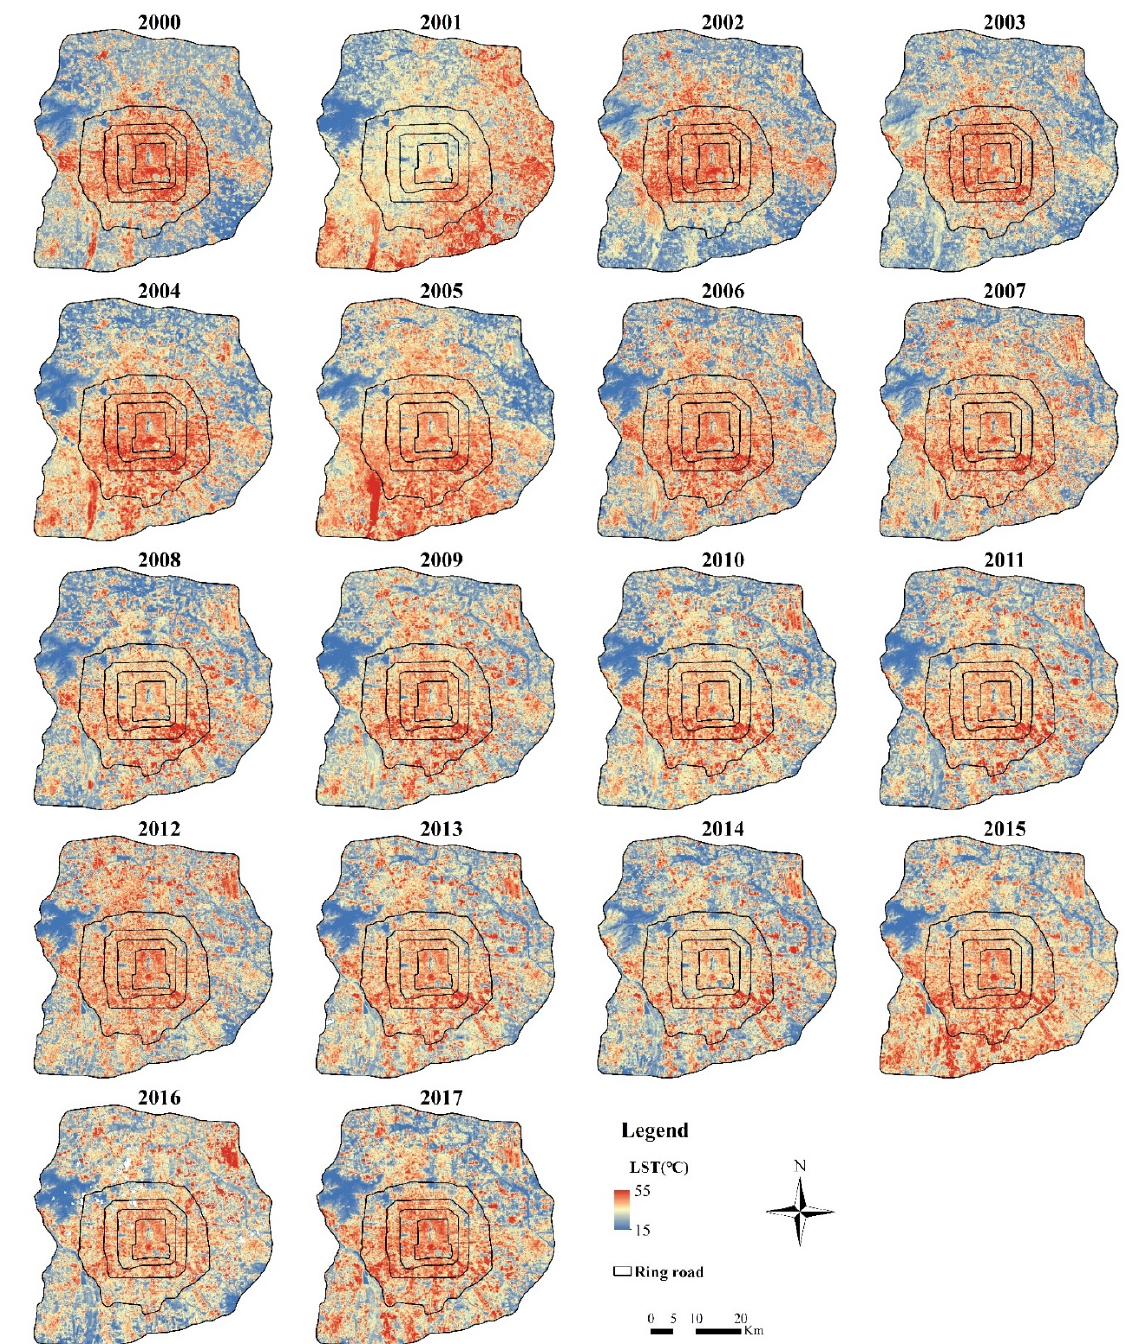
Figure 2. LST distribution maps from 2000 to 2017.